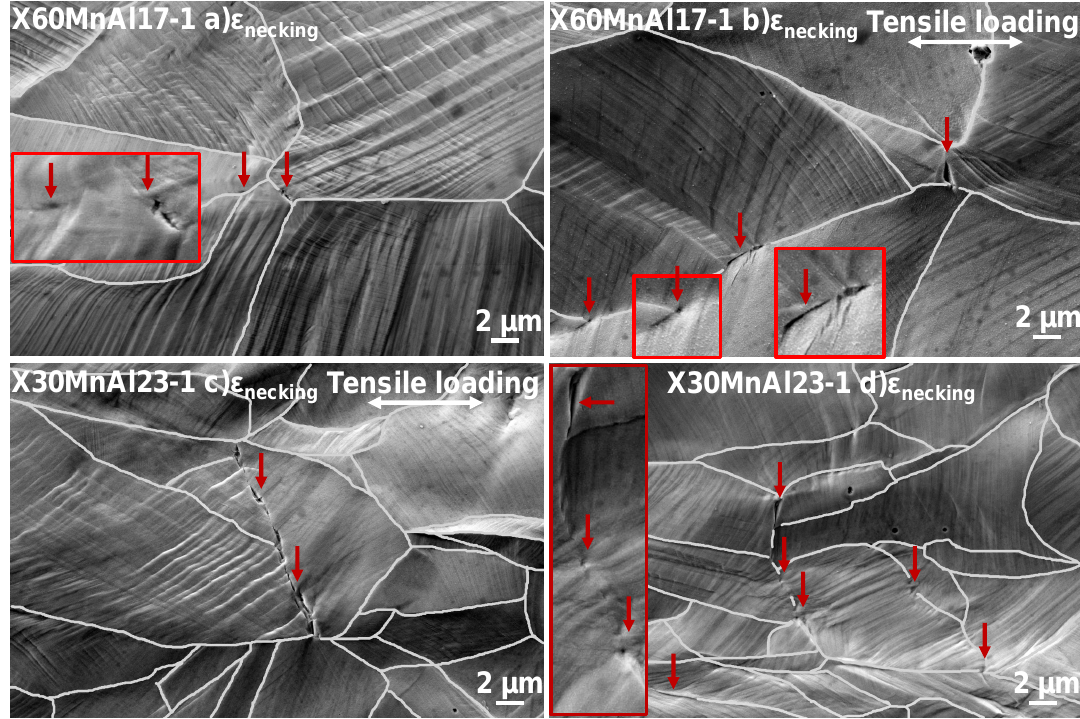
Figure 10. Mechanism of micro-cracks development at a strain of ε necking . X60MnAl17-1 ( a ) Micro-crack initiation at triple junction and crack propagation into the neighboring grains assisted by the intercepting deformation twins, ( b ) Intergranular cracks nucleating at GB, X30MnAl23-1: ( c ) Micro-cracks initiation at GB and their propagation, ( d ) Intergranular cracks nucleation at grain boundaries and triple junctions; red arrows indicate